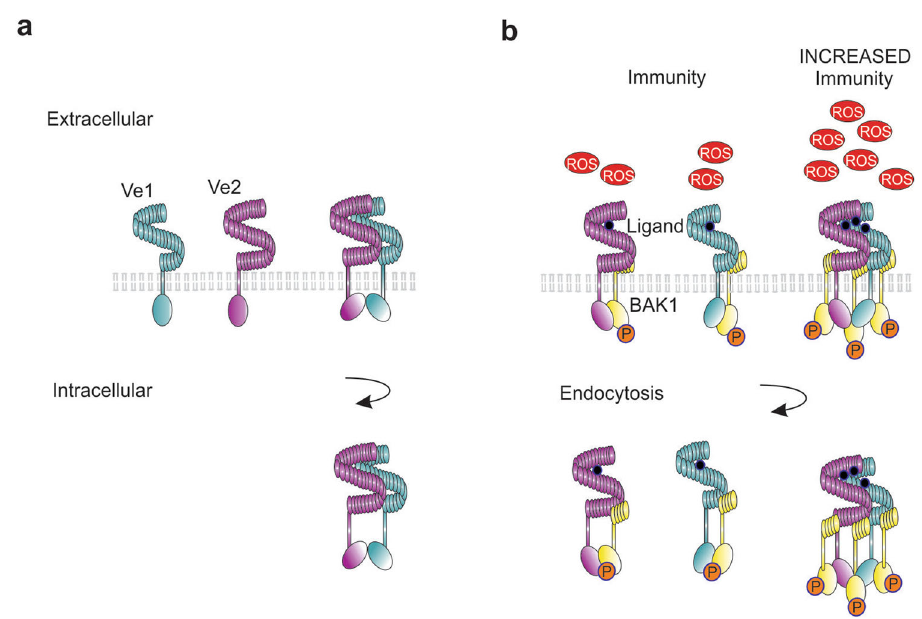
Fig. 6 Formation of a Ve1Ve2 heteromer regulates signaling and increases disease resistance. Illustration of the Ve1 and Ve2 heterodimer showing the predicted primary interface of the receptors based on TLR complexes. Model for oligomerization places the two C-termini, transmembrane helices, and intracellular signaling domains in close spatial proximity. In the inactive state ( a ), Ve1 and Ve2 reside at the cell-surface as individual receptors and heteromerization occurs, inducing pathogen-independent endocytosis and removal. Infection by the fungal pathogen ( b ) introduces ligand recognized by Ve1 and Ve2 that induces heterocomplexes with kinases such as BAK1 and subsequently initiates pathogen induced endocytosis and signal attenuation by the activated immunity receptors. Through the formation of Ve1Ve2 heterocomplexes the immunity receptors amplify signal transduction to elevate early dying disease resistance and stimulate a reactive oxygen species (ROS)